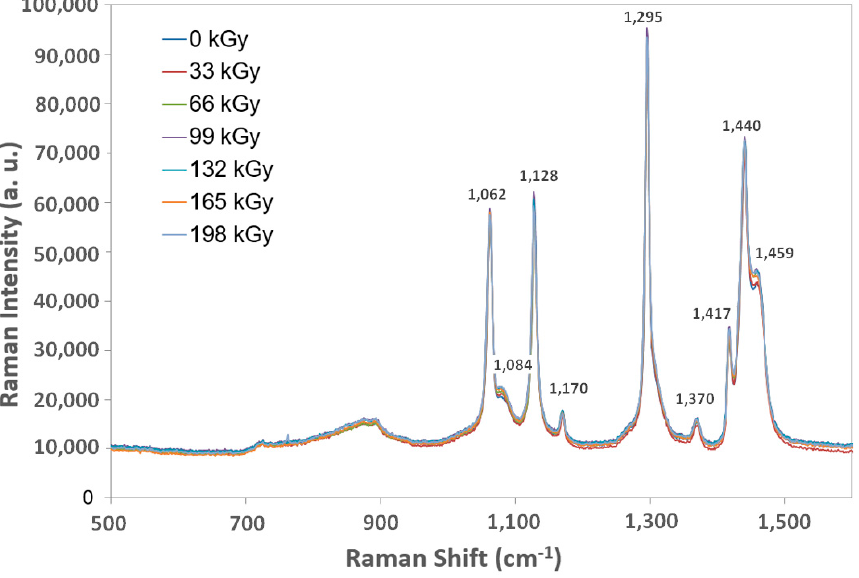
Figure 16. Raman spectroscopy of irradiated LDPE. Materials 2020 , 13 , x FOR PEER REVIEW